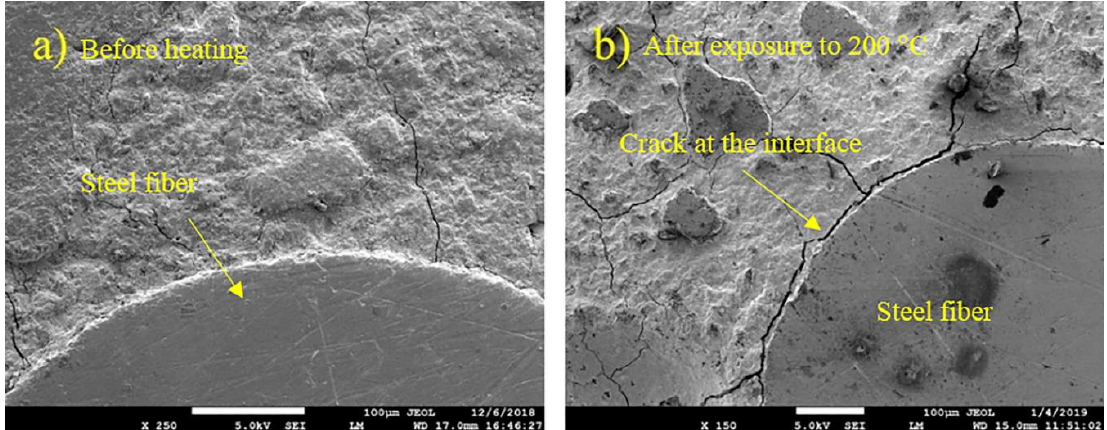
Figure 14. SEM micrographs of SF-based FRAC demonstrating SF and concrete matrix interaction ( a ) before heating and ( b ) after heating at 200 °C. Copyright permission is obtained from [143].